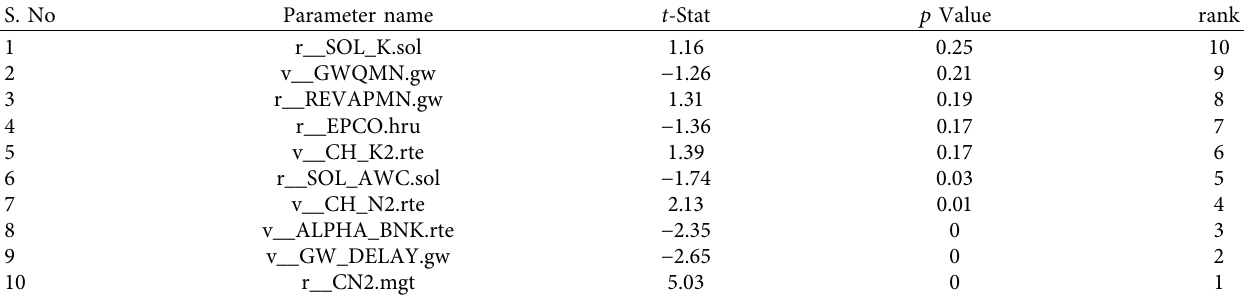
Table 6: Monthly most sensitive parameters of the watershed.